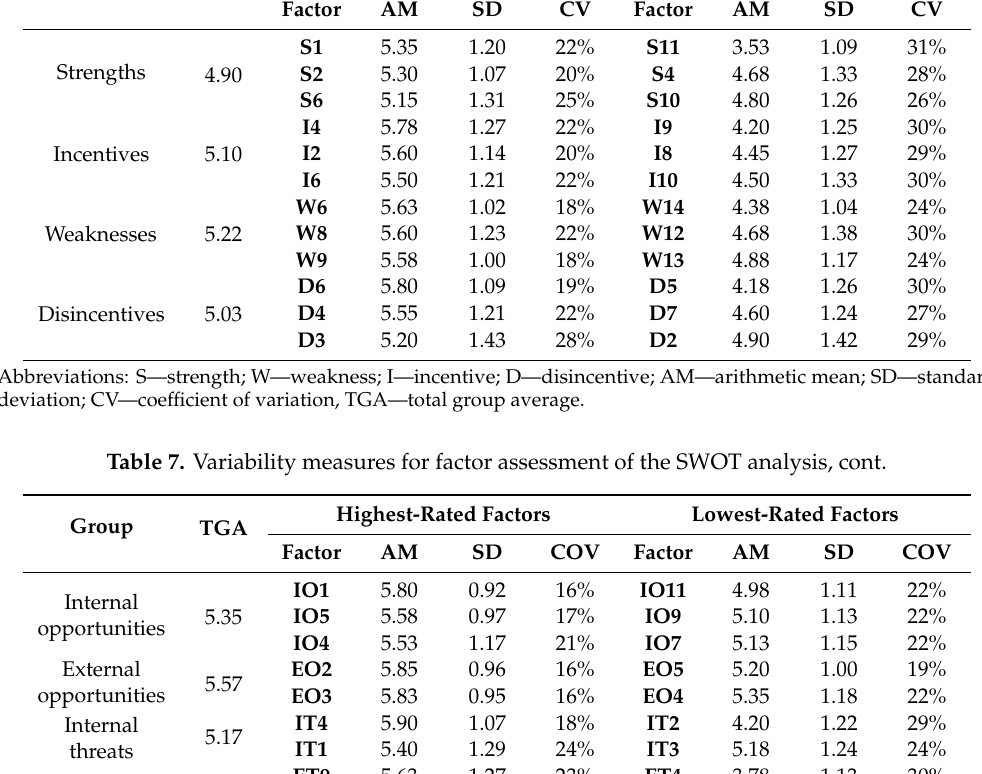
Table 6. Variability measures for factor assessment of the SWOT analysis. Group TGA